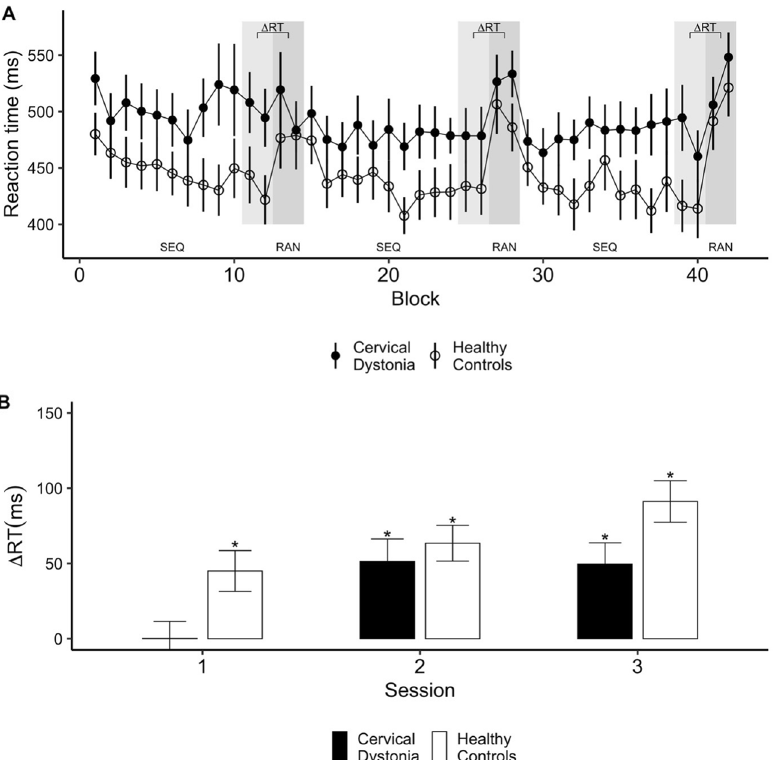
Figure 1. Motor sequence learning. ( A ) Performance in the motor sequence learning task is shown as median reaction time (RT) ± SE for runs of 12 trials. Each block consisted of 12 × 12 sequence trials (SEQ) and 2 × 12 random trials (RAN). Grey bars indicate data points used to characterize sequence learning as ΔRT = RT RAN − RT SEQ . ( B ) ANOVA showed reduced sequence learning in cervical dystonia (CD) in general, and pairwise t-tests demonstrated no learning at all in session 1 in CD. *Significant learning (p < 0.05, Bonferroni